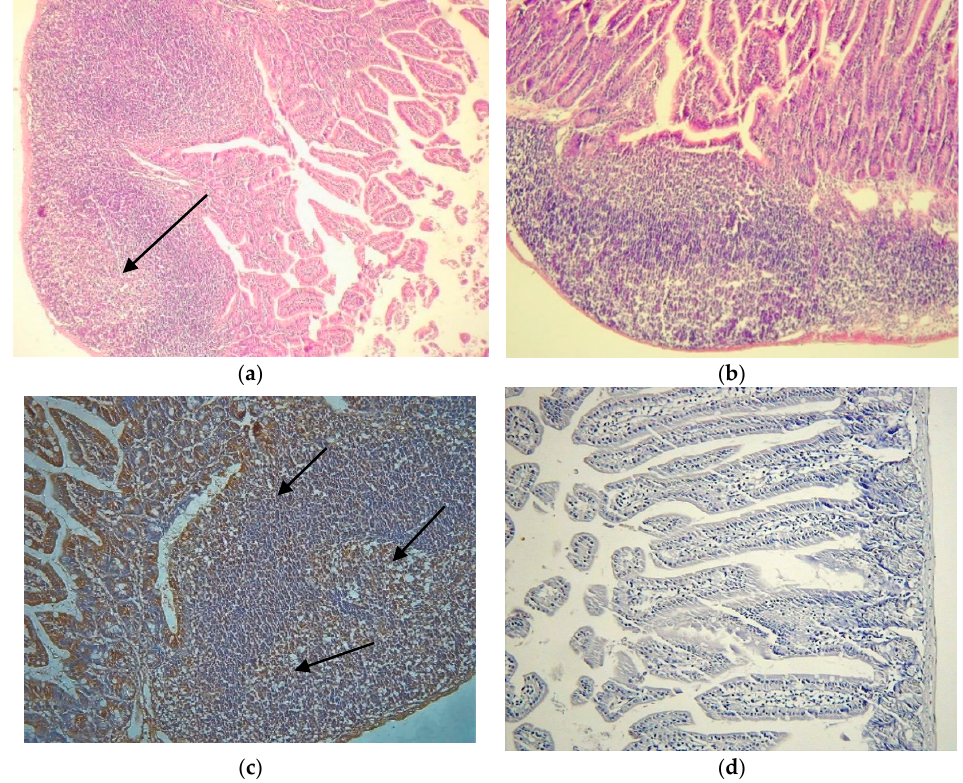
Figure 1. Peyer’s patches (PP). ( a ) Hematoxylin eosin staining of a typical PPs with enlarged germinating centers at day 7 post infection (p.i.) of orally infected mouse with CVB3-Nancy, Set 1 (20×); ( b ) normal PP of the mock infected control mouse at day 7 p.i. of an orally infected mouse, Set 1 (20×); ( c ) Localization of IFN- α in the PP, the brown staining, by immunohistochemical analysis (40×), Set (I) at day 3 p.i. (40×); ( d ) Small intestine sample of mock infected control mouse from Set I at day 3 p.i. (20×).